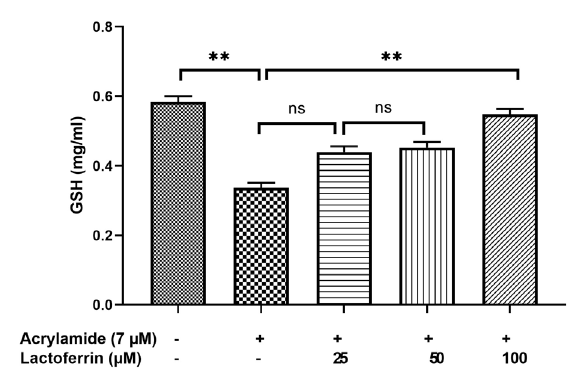
Figure 5. Protective effect of lactoferrin on glutathione reductase against acrylamide-induced oxidative stress in HepG2 cells. The results were shown with mean±standard deviation. ns: not significant, ** p <